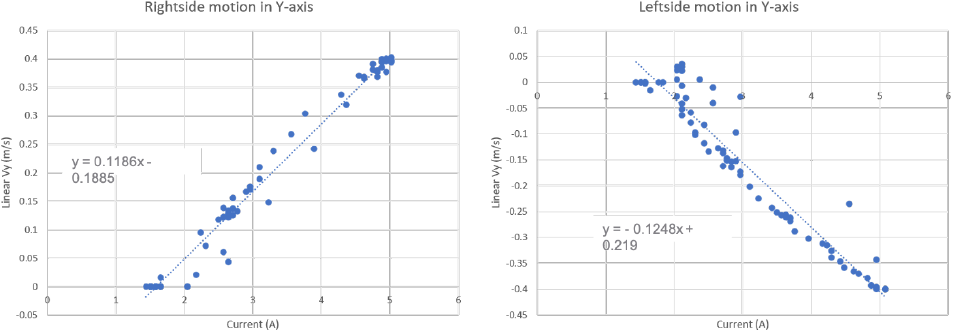
Figure 8. Relation between Current consumption and Linear Vy for the cleaning robot.